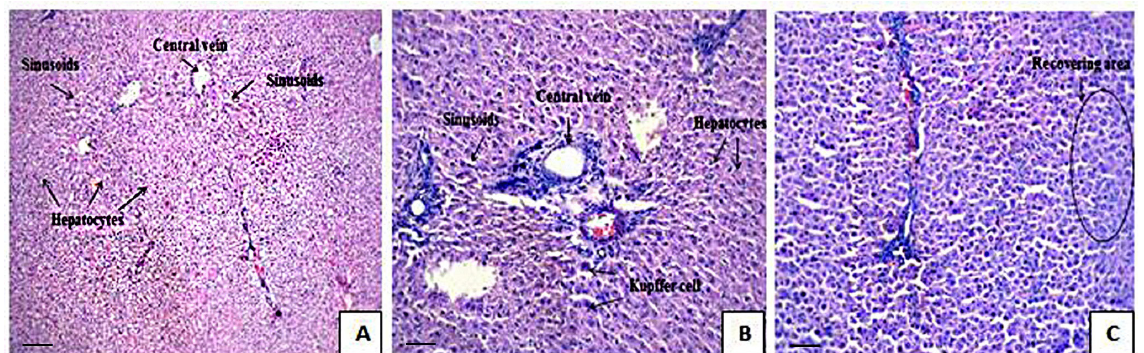
FIGURE 5 - Histopathological Examination. Tumor slices stained with hematoxylin and eosin. The slices were prepared from the margin of xenografts, and the necrotic area in the paclitaxel & spirulina nanoparticle group is significantly increased compared with that of the other groups. (A. Normal control) sheets of prominent hepatocytes, sinusoids & central vein; (B. Tumor control)hepatic congestion at sinusoids and the portal vessel, pericentre globular micro-steatosis, Kupffer cell proliferation and hepatocyte diffuse necrosis; (C. paclitaxel & spirulina nano particle treated) No hepatic congestion at sinusoids and the portal vessel, pericentre globular micro-steatosis, No Kupffer cell proliferation and no hepatocyte diffuse necrosis. (Scale bar 50